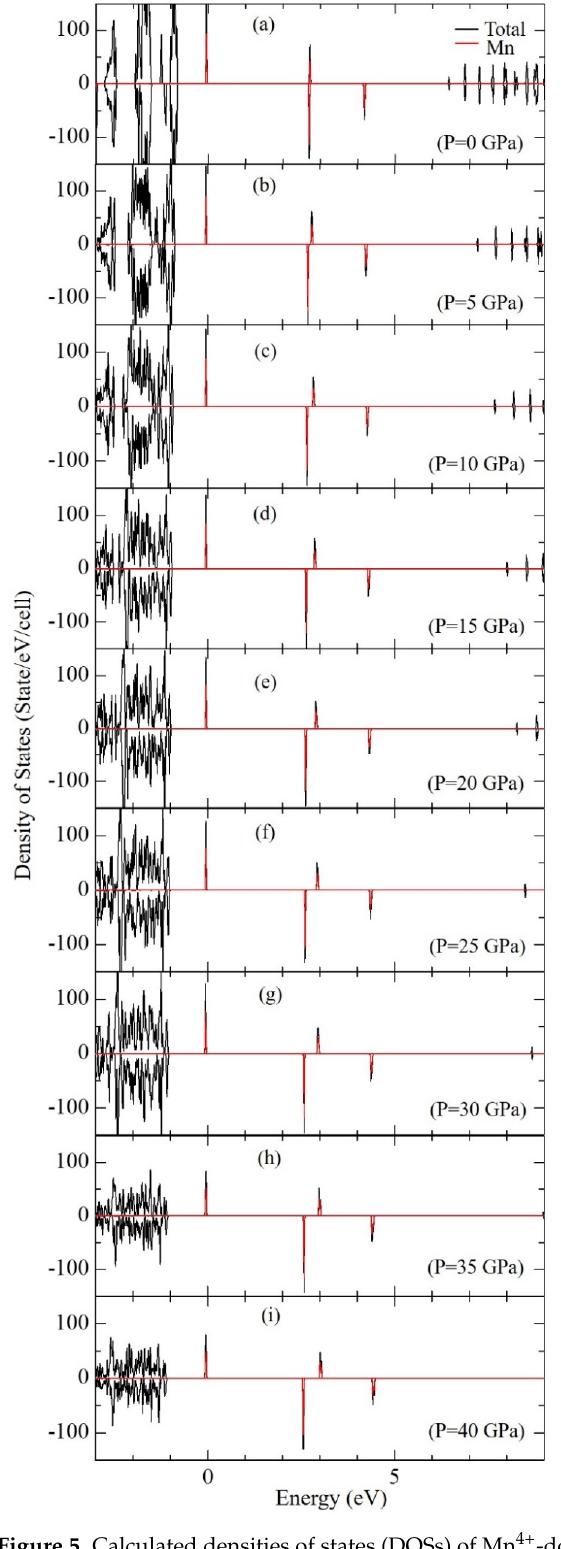
Figure 5. Calculated densities of states (DOSs) of Mn 4+ -doped K 2 SiF 6 at P = ( a ) 0, ( b ) 5, ( c ) 10, ( d ) 15, ( e ) 20, ( f ) 25, ( g ) 30, ( h ) 35 and ( i ) 40 GPa, respectively.